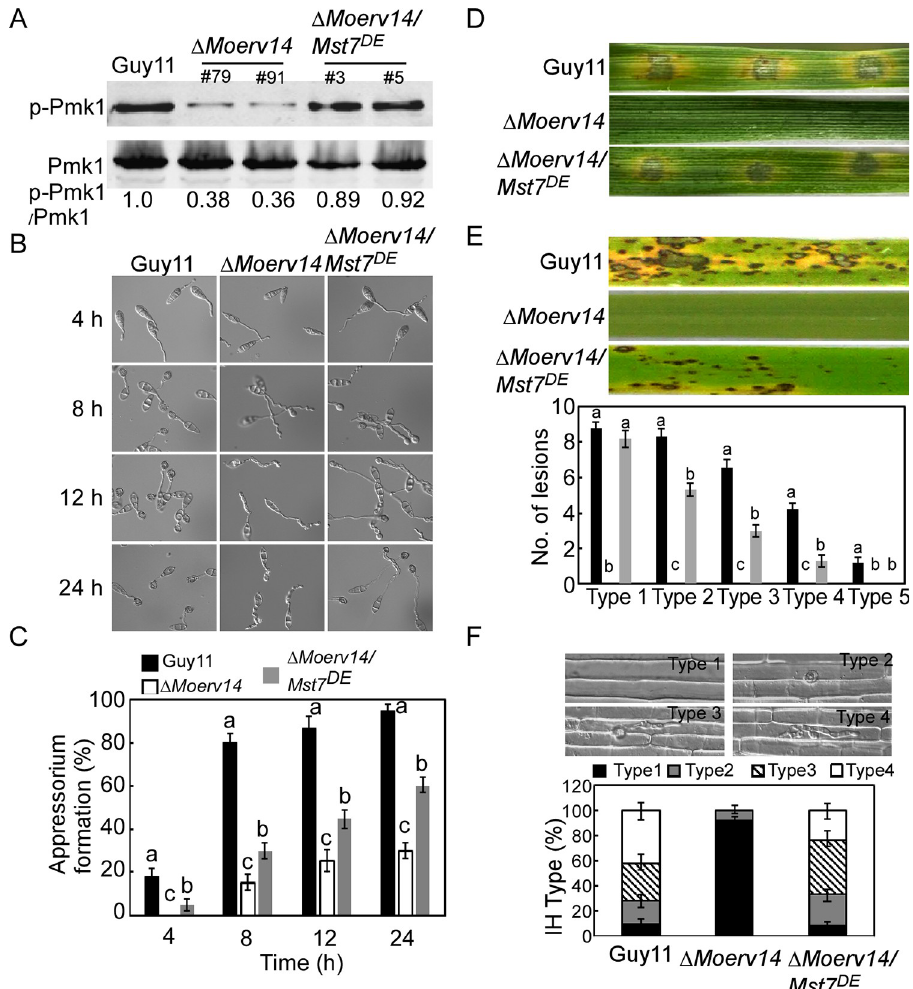
Fig 5. Activating the Pmk1-MAPK signaling pathway suppresses the defect of appressorium formation in the Δ Moerv14 mutant. (A) Pmk1 phosphorylation level analysis with proteins extracted from the mycelia of Guy11, Δ Moerv14 mutant, and Δ Moerv14/Mst7 DE . The phosphorylation levels of Pmk1 (42-kDa) were detected using a phosphor-MAPK antibody (upper panel). The endogenous Pmk1 was detected using a MAPK antibody (lower panel). (B) Appressorium formation assay on the hydrophobic surfaces at 4 h, 8 h, 12 h and 24 h, respectively. (C) Appressorium formation rates were calculated and statistically analyzed. Asterisks represent significant differences ( p < 0 . 01 ).(D) Pathogenicity assay on detached barley leaves. (E) Pathogenicity assay on rice (CO-39) and the quantification of the lesion numbers per 5 cm length of rice leaf. Error bars represent SD and different numbers denote statistical significances ( p < 0.01). (F) Penetration assays in rice sheath. IH growth on rice cells was observed at 24 hpi and 4 types of IH were quantified and statistically analyzed. Error bars represent SD. Asterisks represent expanded IH.